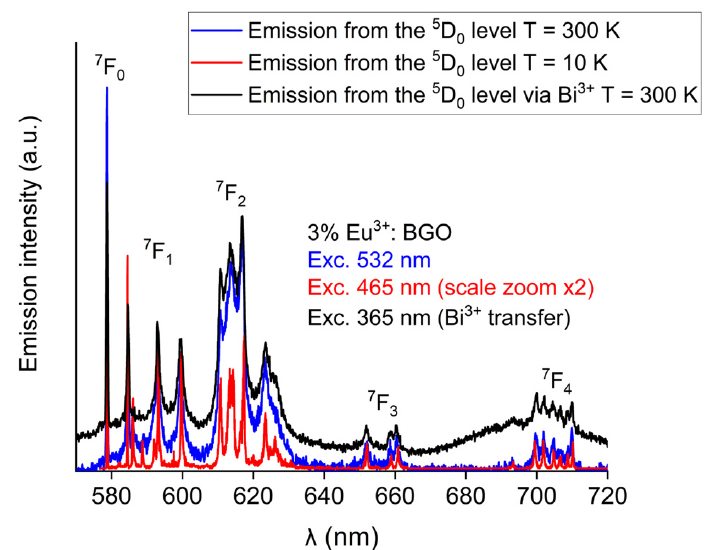
Figure 5 . 5 D 0 level emission spectra of BGO: 3% Eu 3+ .